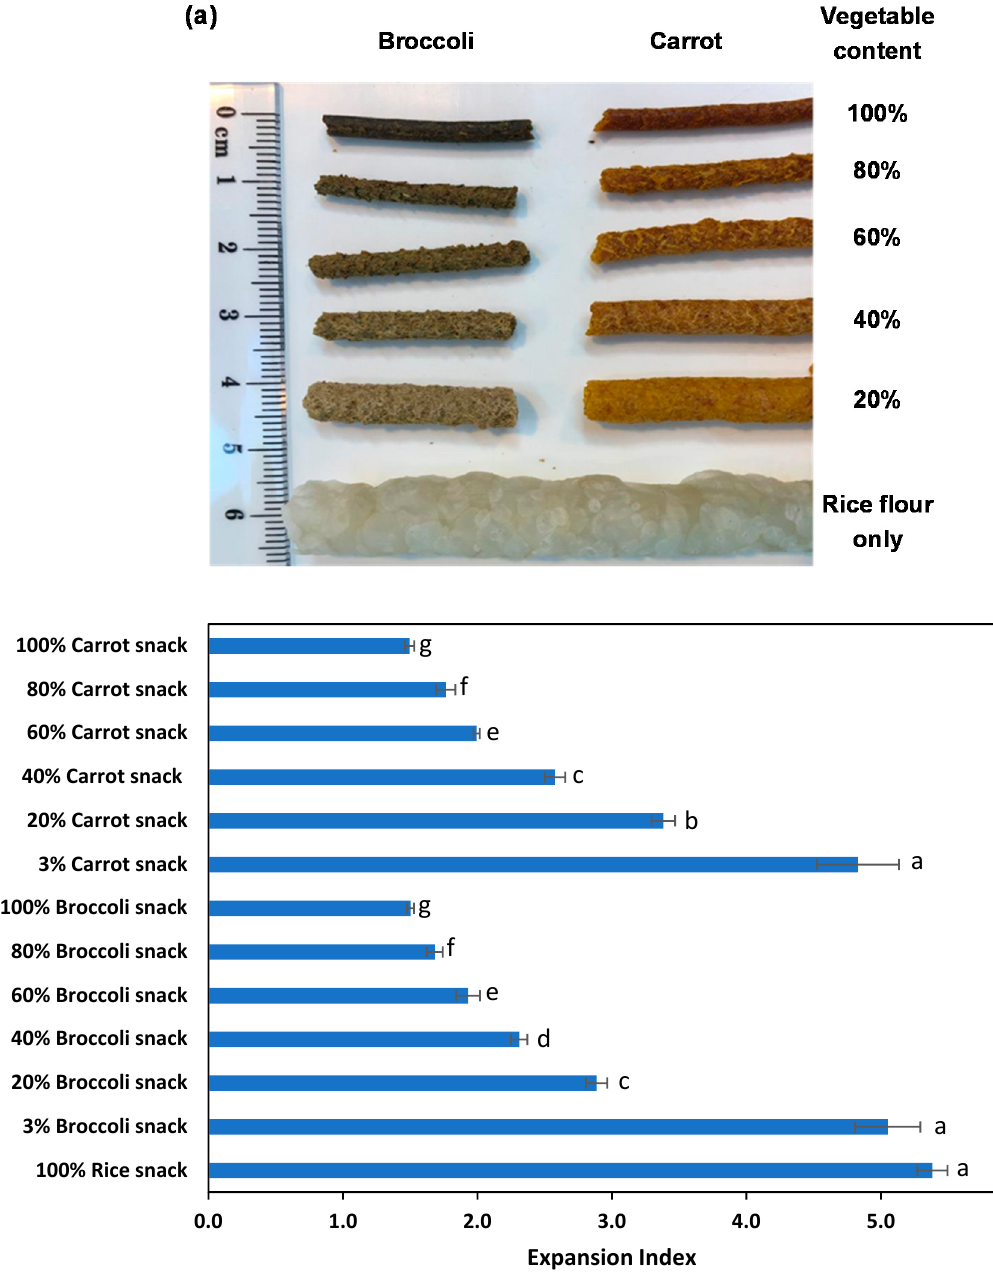
Figure 4. Extruded snacks containing various ratios of the whole-vegetable powder: Rice flour using powders from Trial 2 and pomace from Trial 1. ( a ) Images of snacks and ( b ) expansion index (error bar is the standard deviation of 10 measurements). Note: 3% Carrot snack and 3% Broccoli snack were made from wet pomace (from Trial 1) and rice flour. Different lowercase letters indicate that there is a significant difference, p < 0.05.